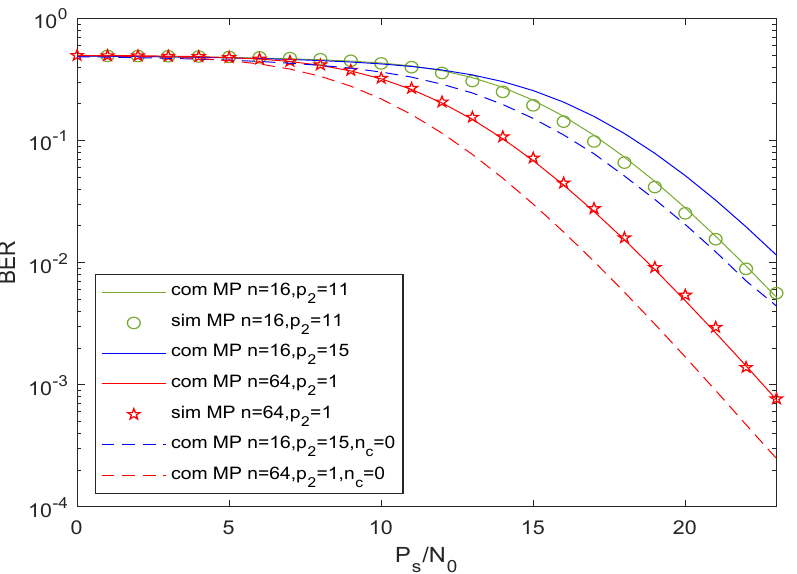
Figure 7. Simulations and analytical BER performance of GCI-DCSK SWIPT over multipath Rayleigh fading channel with d tr =